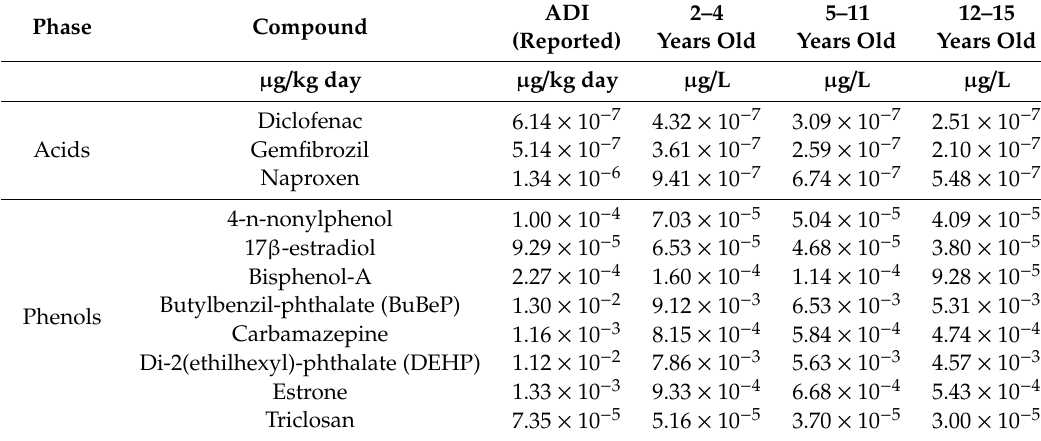
Table 7. Age-dependent risk quotient (RQ) for Mezquital Valley groundwater.